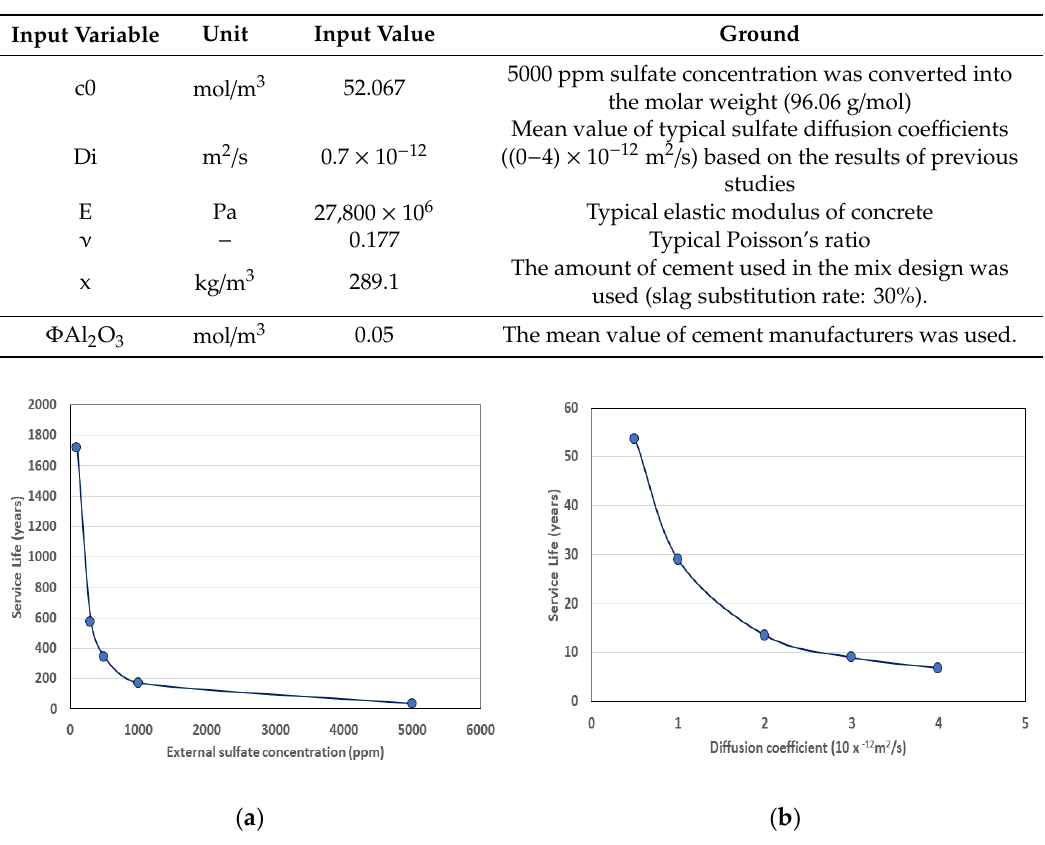
Figure 5. ( a ) Service life variation with exterior concentration; ( b ) service life with diffusion coefficient of sulfate ion.